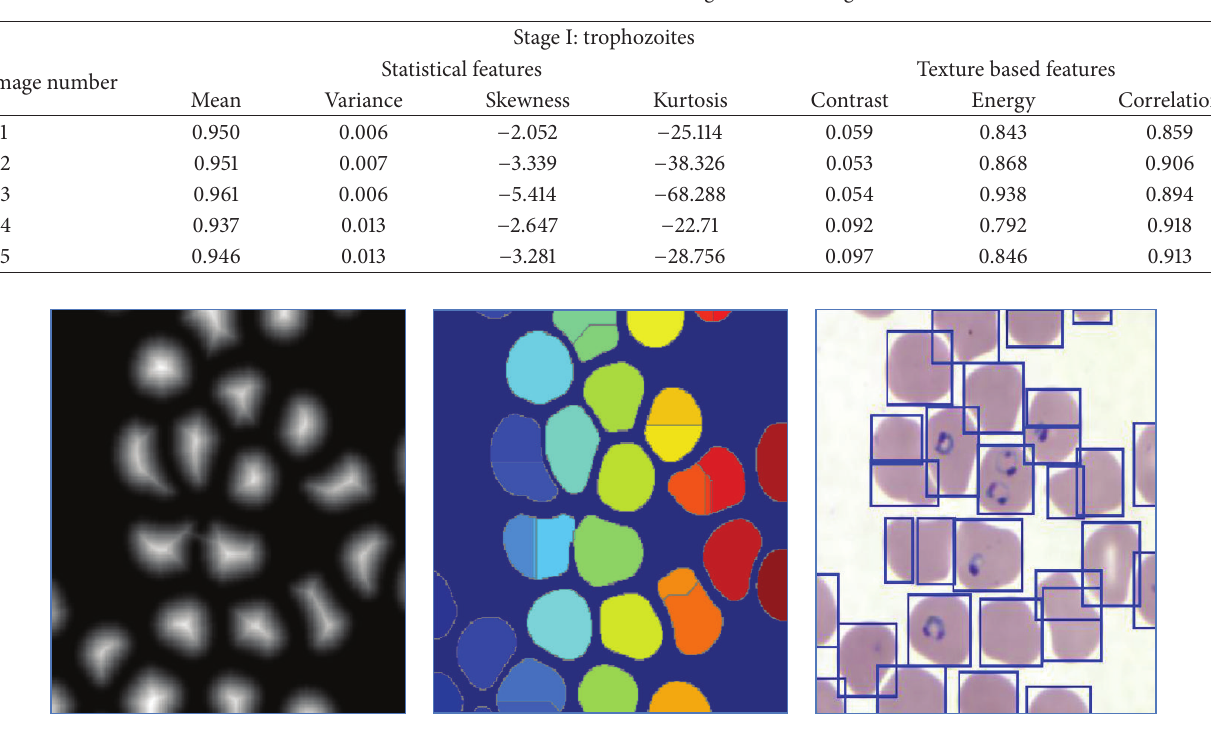
Table 1: The values obtained while training dataset for stage I.